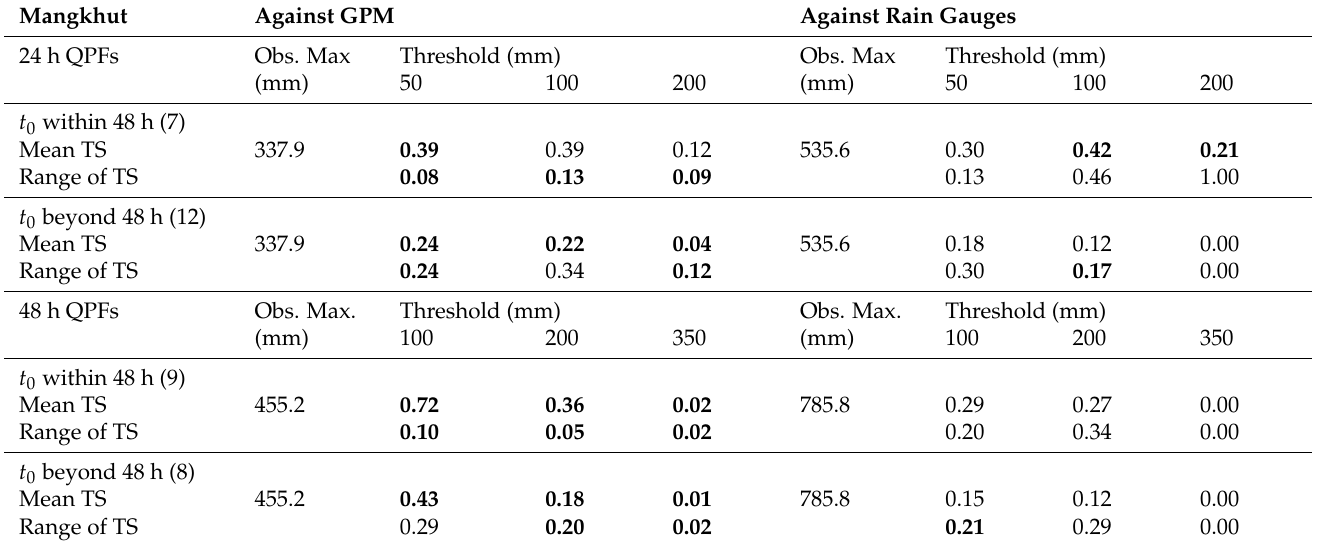
Table 2. Comparison of mean TS values and their range (maximum minus minimum) with the CReSS hindcasts for TY Mangkhut (2018) obtained against the GPM retrievals (left) and the rain gauges (right) in each category: 24 h (top half, for 15 September) and 48 h QPFs (bottom half, for 14–15 September, both in UTC) within the short range for the day 1 forecast ( t 0 ≤ 48 h before the beginning of accumulation) and at longer ranges beyond. For each range group, the number of lagged runs was given in the parentheses and the three highest thresholds available were selected (based on the observed peak rainfall amount). Bold faces indicate the better result between the two data sources: a higher score but smaller range (except for mean TS =